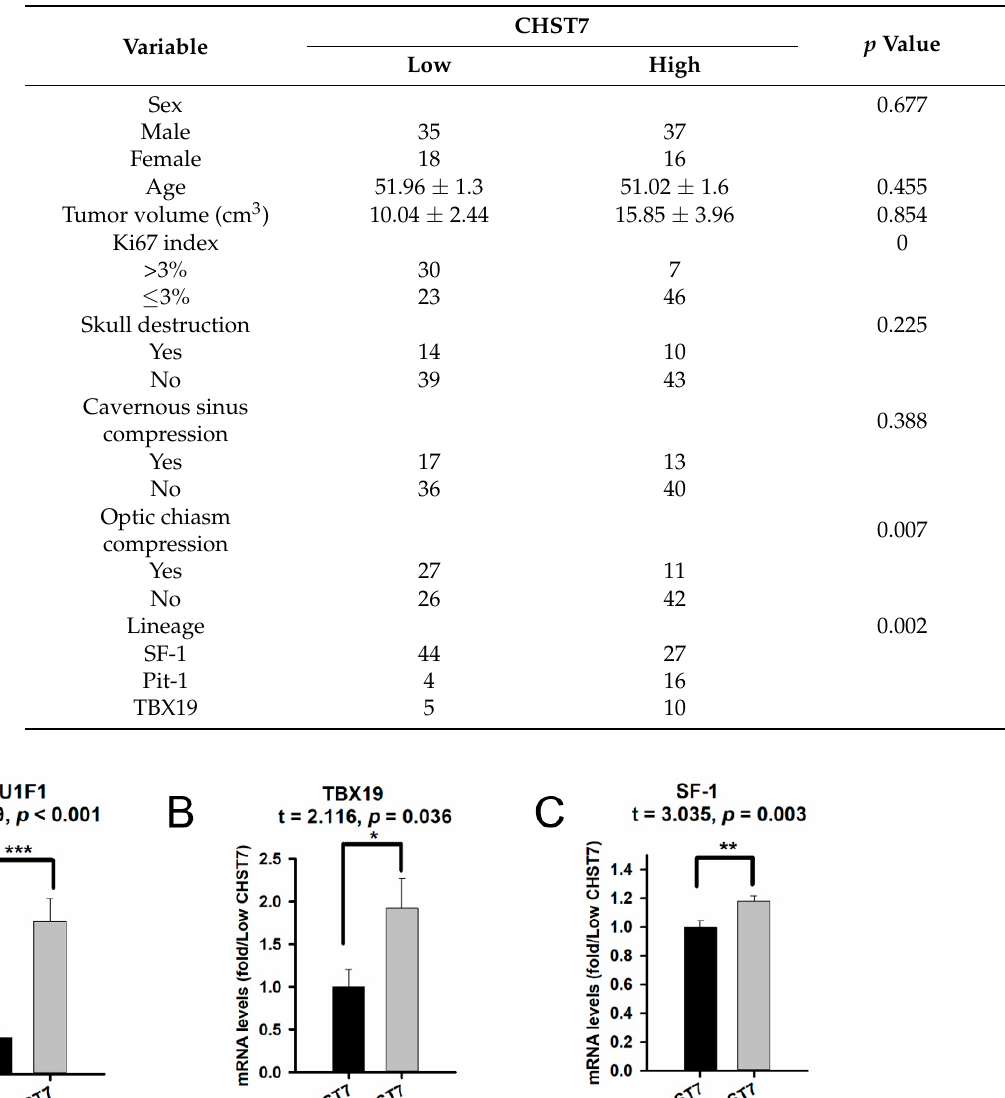
Table 3. Association between CHST7 expression and clinicopathological characteristics.